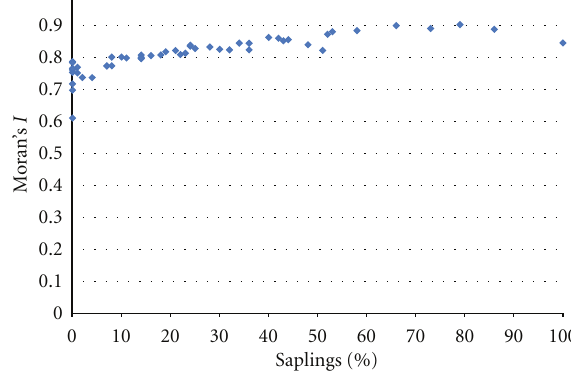
Figure 13: Moran’s I versus sawtimber.